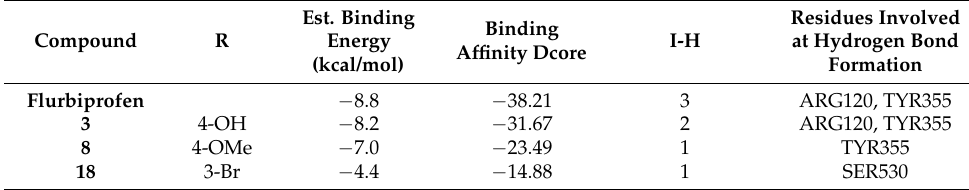
Table 3. COX1: PDB1D: 1EQH binding affinities.